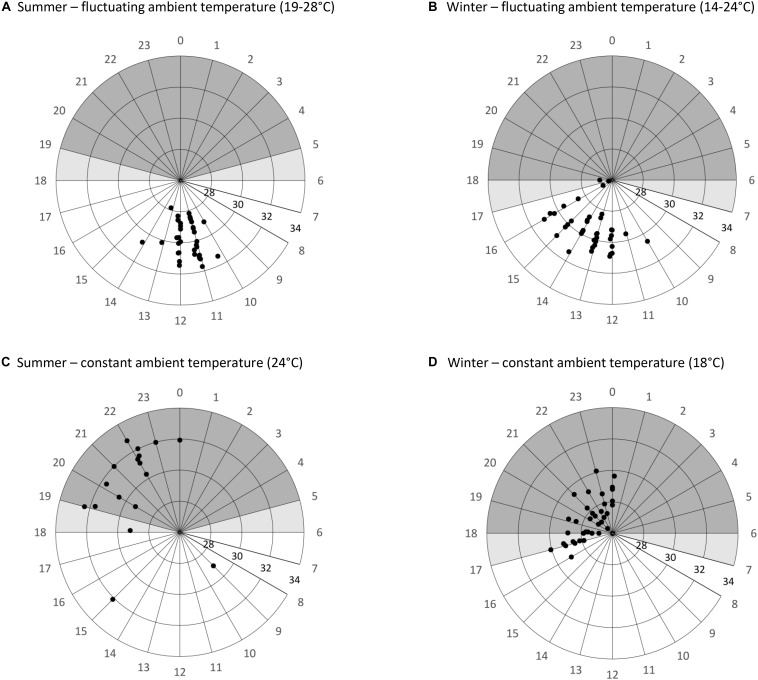
Timing of arousals (initiation of endogenous heat production) and maximum skin temperature during arousals/activity phases of Echinops telfairi for four experimental treatments (A–D). Data shown indicate the time of day (degrees) and level of maximum skin temperature (°C; radial distance). Shaded areas illustrate the scotophase, lighter shaded areas the transitional times between night and day phase. Under fluctuating conditions (A,B), arousals are more synchronous and initiated when Tskin passively reaches maximal Tn well before the beginning of the scotophase. Under constant conditions (C,D), the start of arousals is scattered over a longer time period, but almost always only after the beginning of the scotophase. Maximal Tskin is highest during the activity phases under constant summer condition (24°C), and lowest and least variable during the arousals under constant winter conditions (18°C).